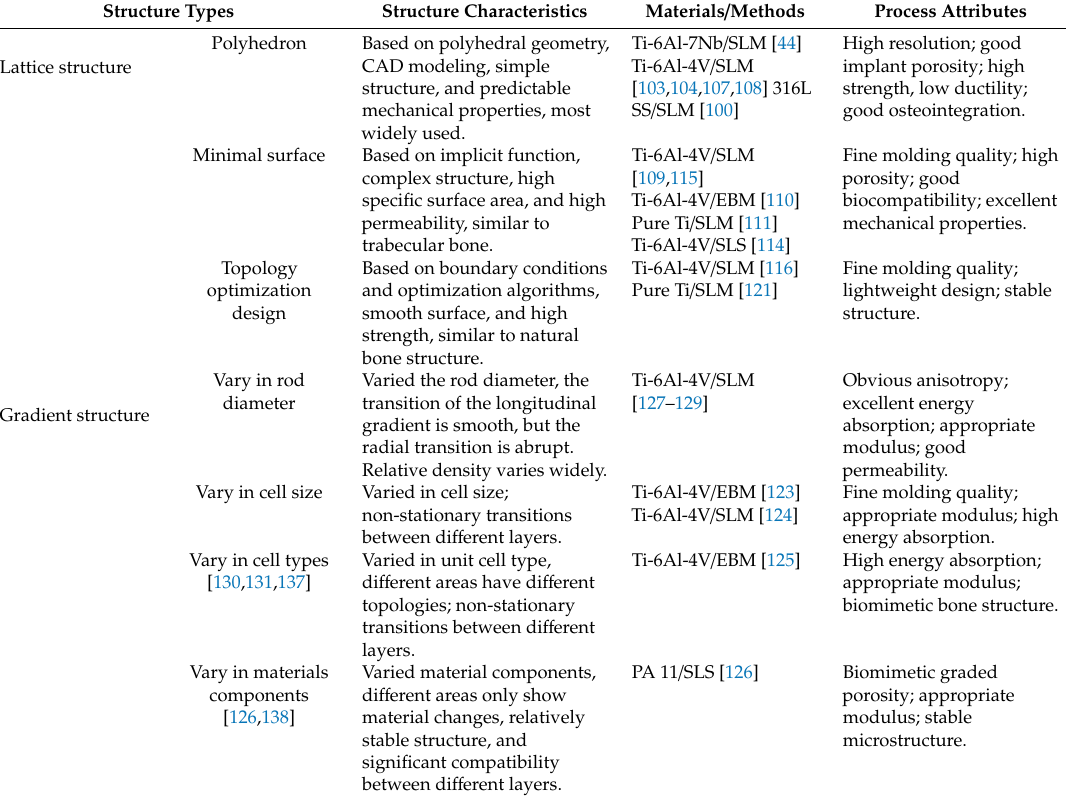
Table 2. Summary of implant structure